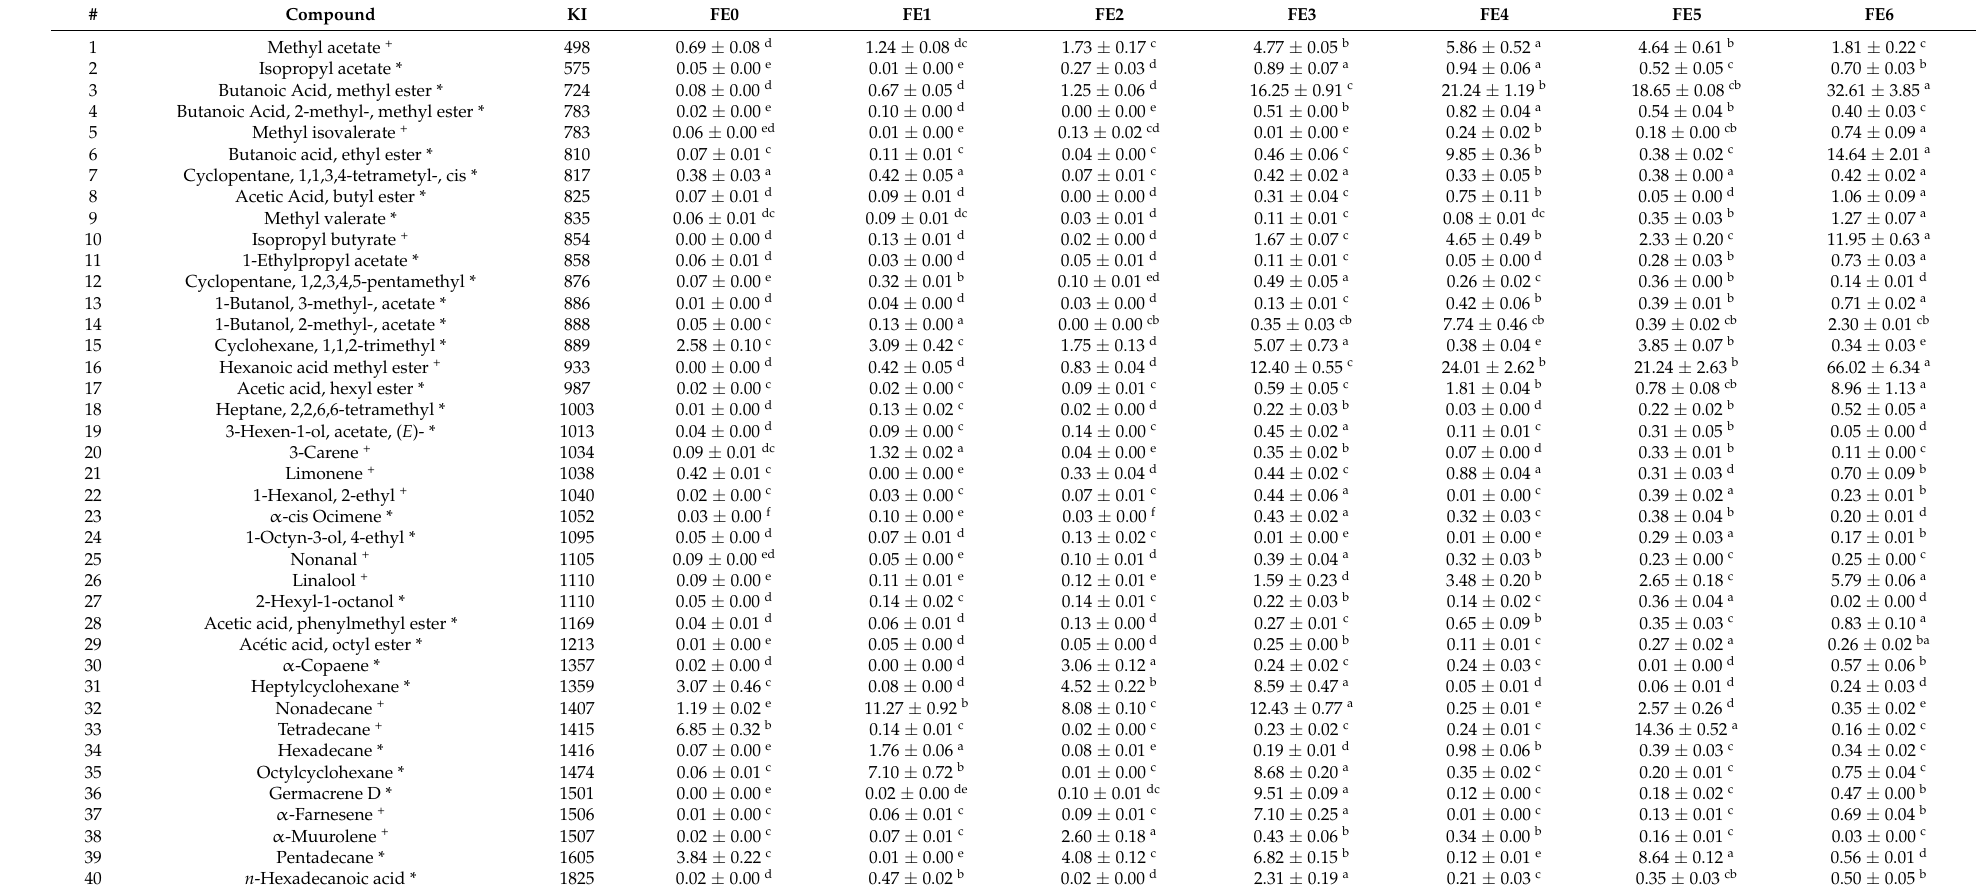
Table 2. Volatile organic compounds related to aroma in Festival variety strawberries at seven stages of